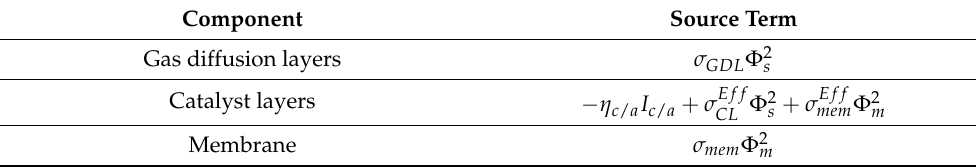
Table 2. Heat transfer source